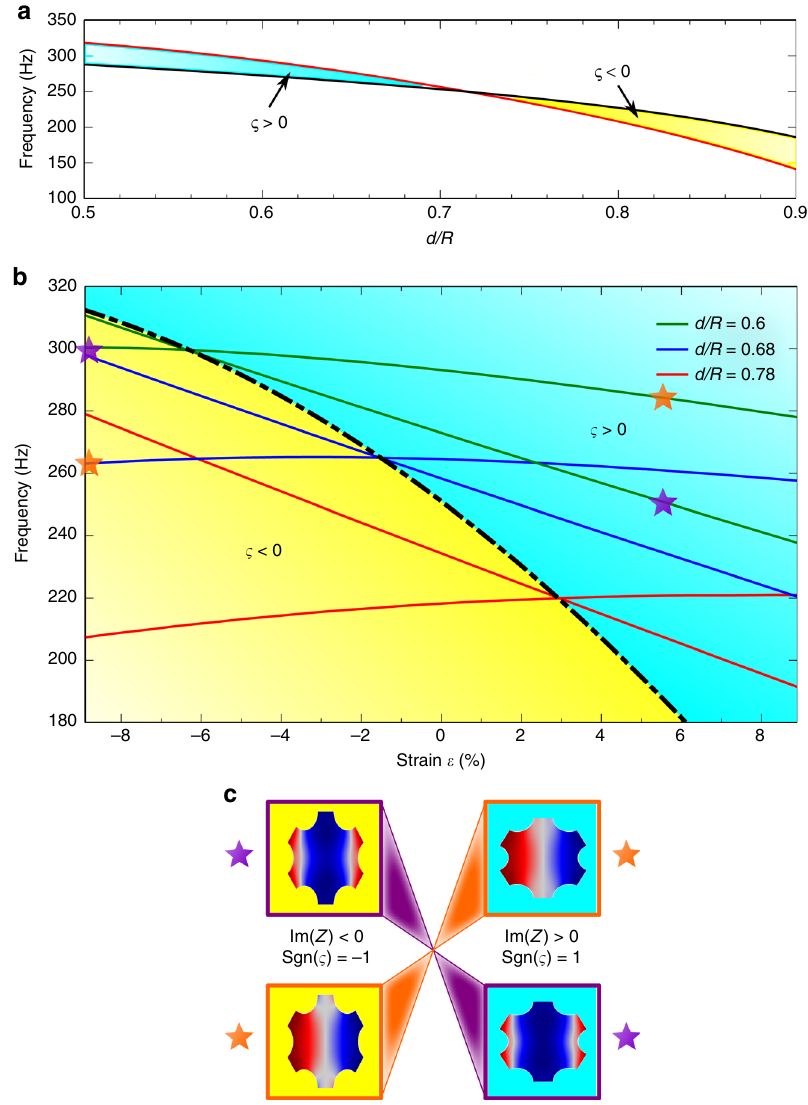
Fig. 2 Topological phase diagram. a The frequencies of two states at M point as a function of fi lling ratio of d / R without applied strain. The bandgap signs of the cyan and yellow regions are ς > 0 and <0, respectively. b Topological phase diagram as a general design scheme consists of two domains separated by topological transition line (black dash-dotted line) that is formed by connecting the topological transition points of different fi lling ratio systems. Green, blue, and red solid lines are obtained by investigating the frequencies of two band-edge states at M point as a function of strain. The bandgap signs ς are marked in the yellow and cyan regions. c Real parts of eigen vertical vibration modes at M point inversion represents topological phase inversion in solid. The vibration modes correspond to the stars marked in b . The imaginary part of surface impedance and bandgap sign are marked between two vibration modes. All data are from numerical Z ( ω , k || ), the topological phase diagram can be considered as the surface impedance diagram as a function of strain. One region (yellow region) with ς < 0 has Z ( ω , k || ) < 0 and the other region (cyan region) with ς > 0 has Z ( ω , k || ) > 0. The real parts of eigen vertical displacement fi elds of the two distinct regions are shown in Fig. 2c, indicating topological phase transition with even and odd Bloch modes alternation. Supplementary Fig. 3.